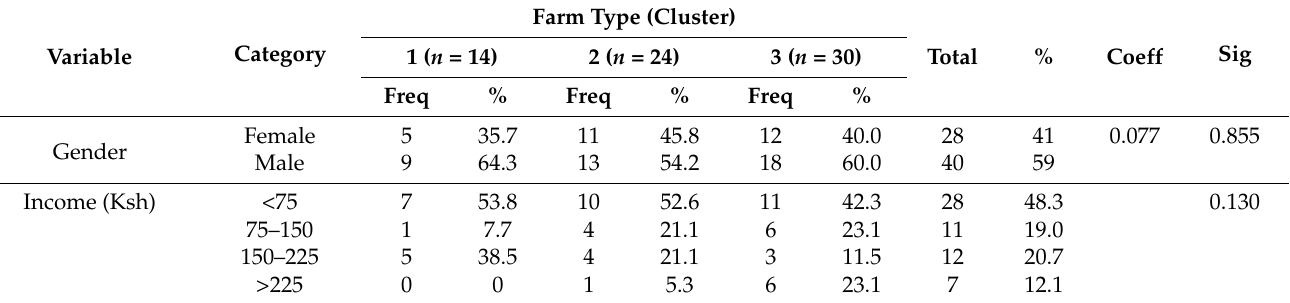
Table 9. Comparison of households’ socio-economic characteristics across the identified farm types in upper Eastern